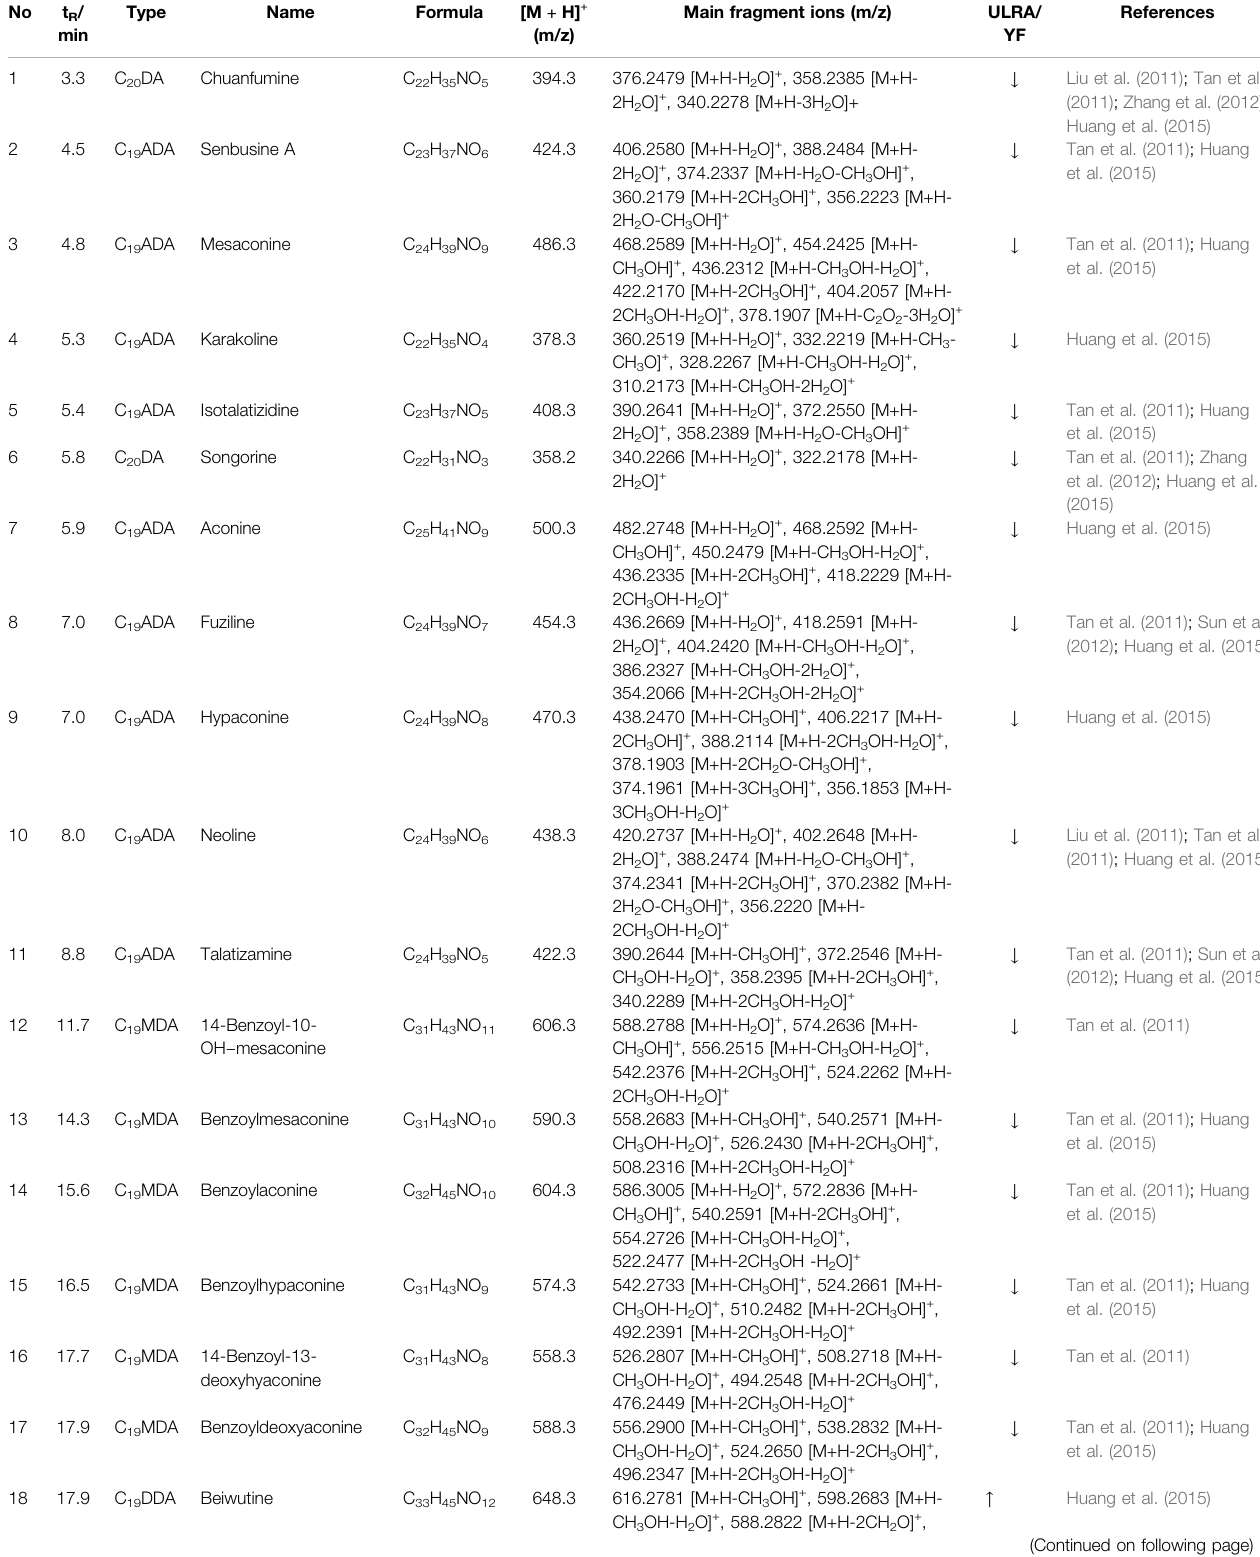
TABLE 3 | Screening and analysis of the components of ULRA and